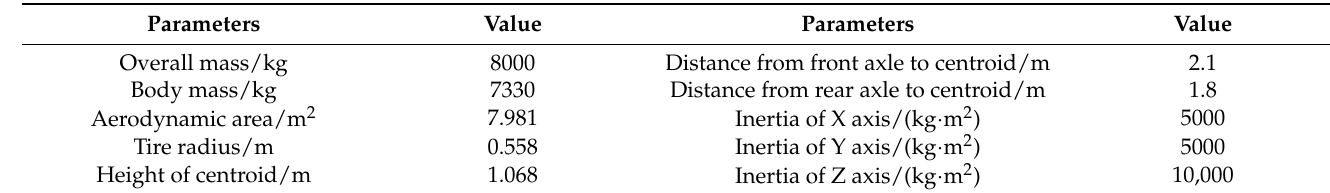
Table 4. Main parameters of virtual